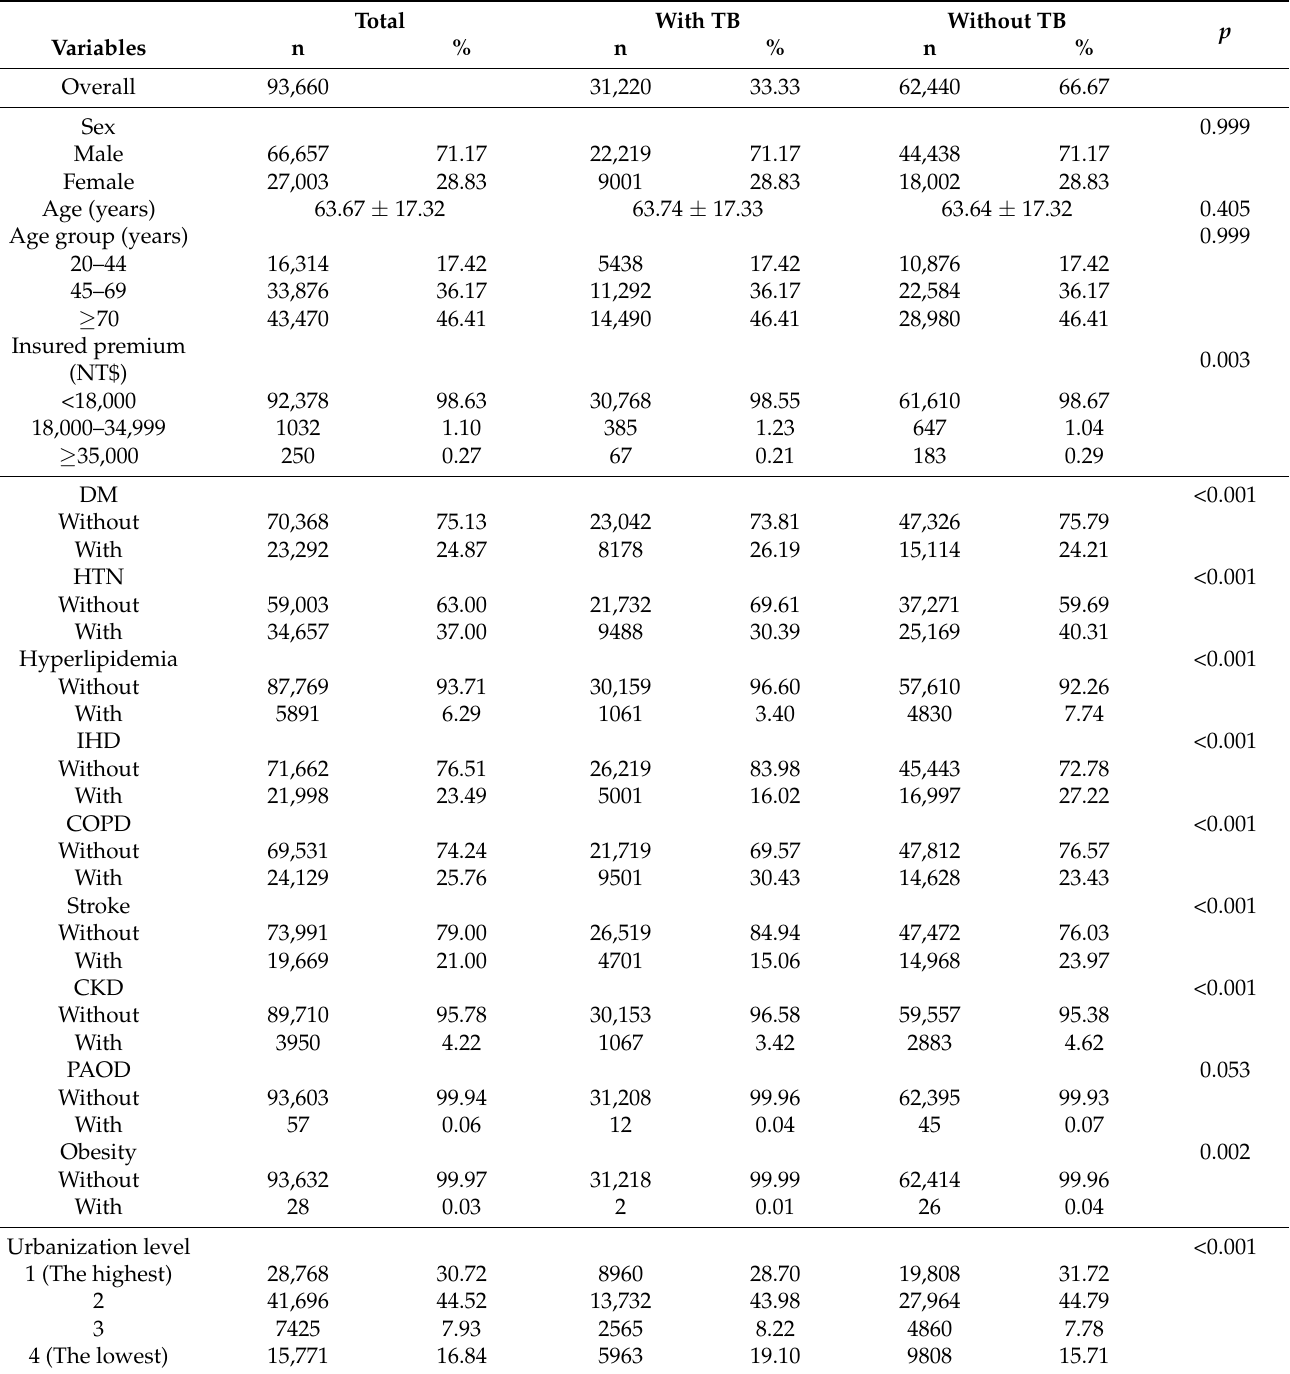
Table 1. Characteristics of the study participants at